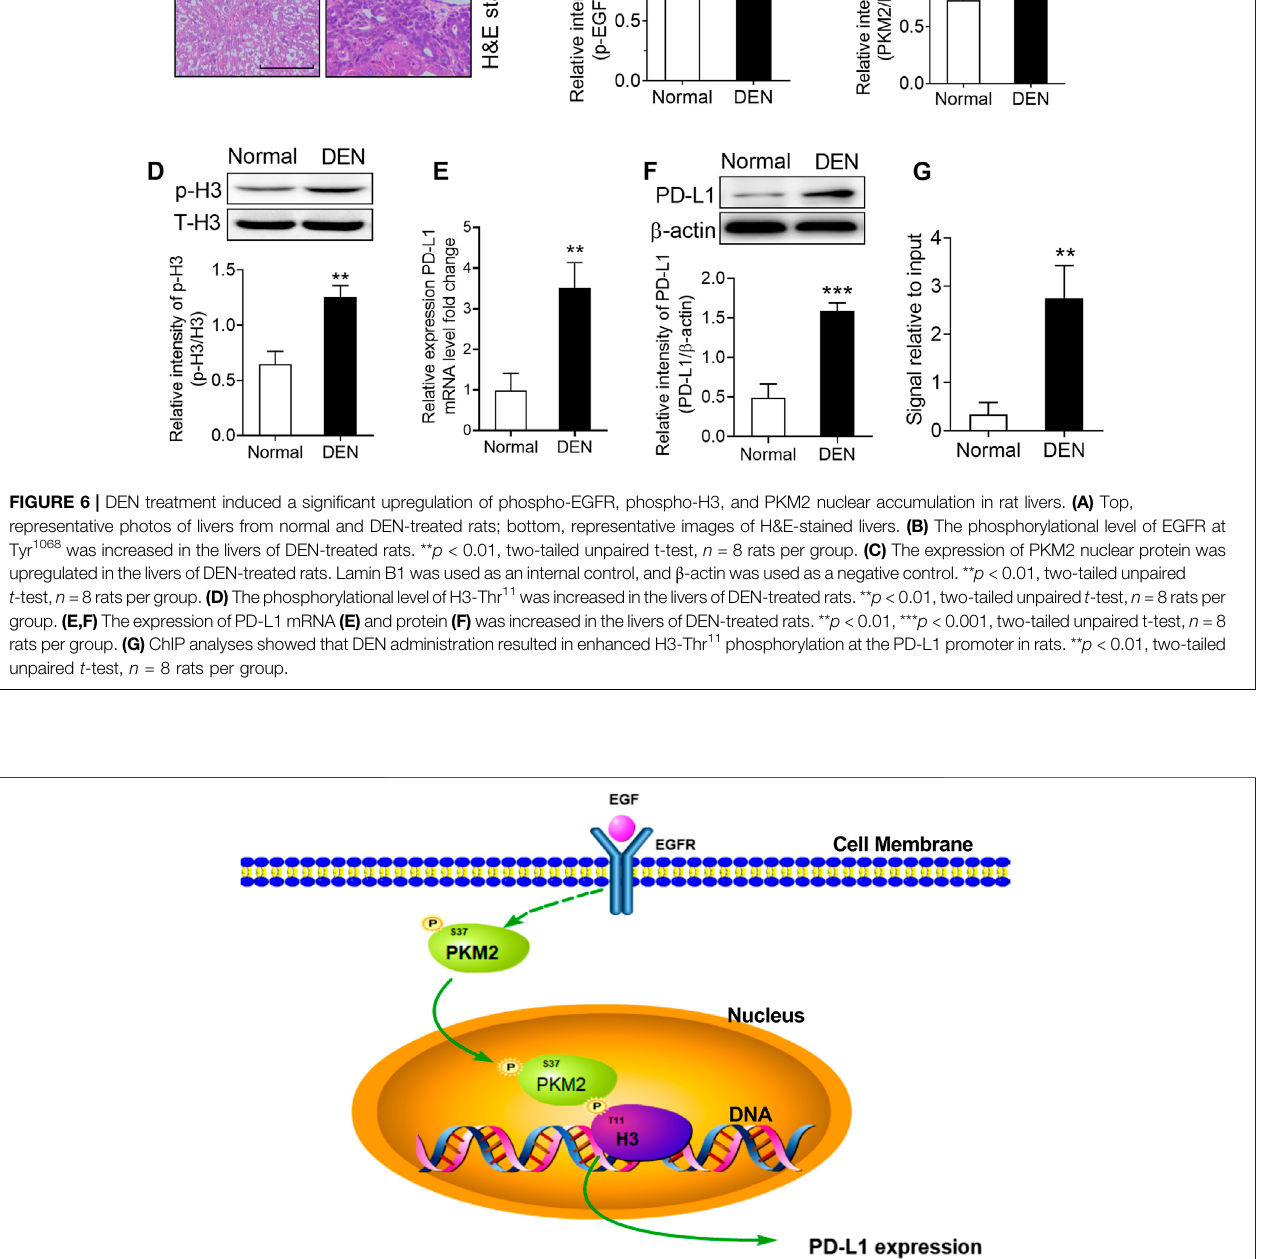
Frontiers in Pharmacology |